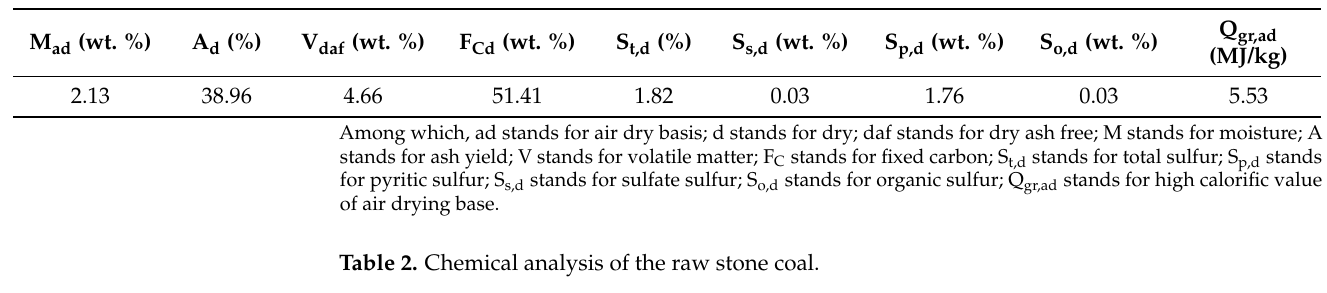
Table 1. Proximate and ultimate analysis in the raw coal sample.